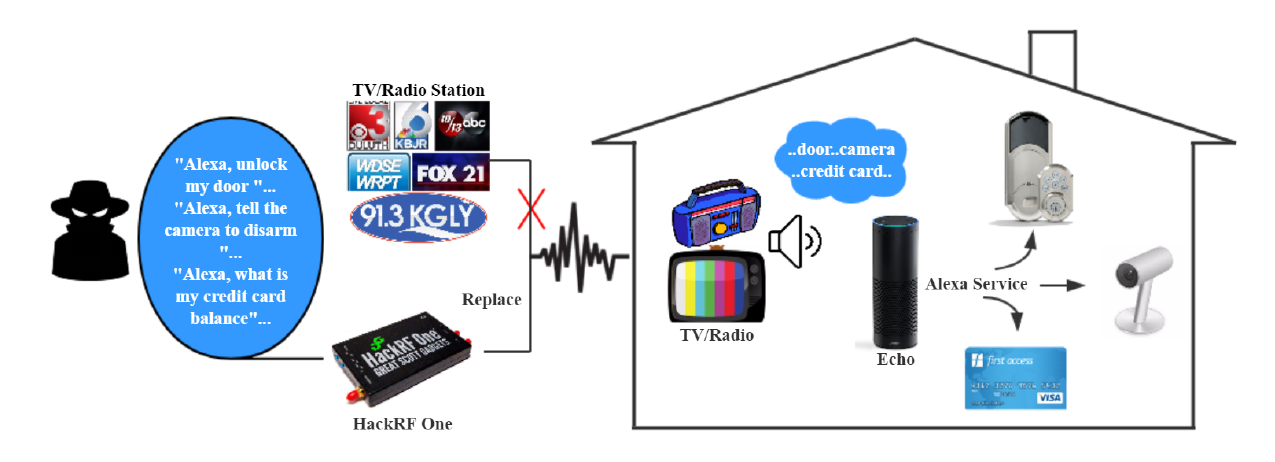
Figure 1. MUTAE Attack